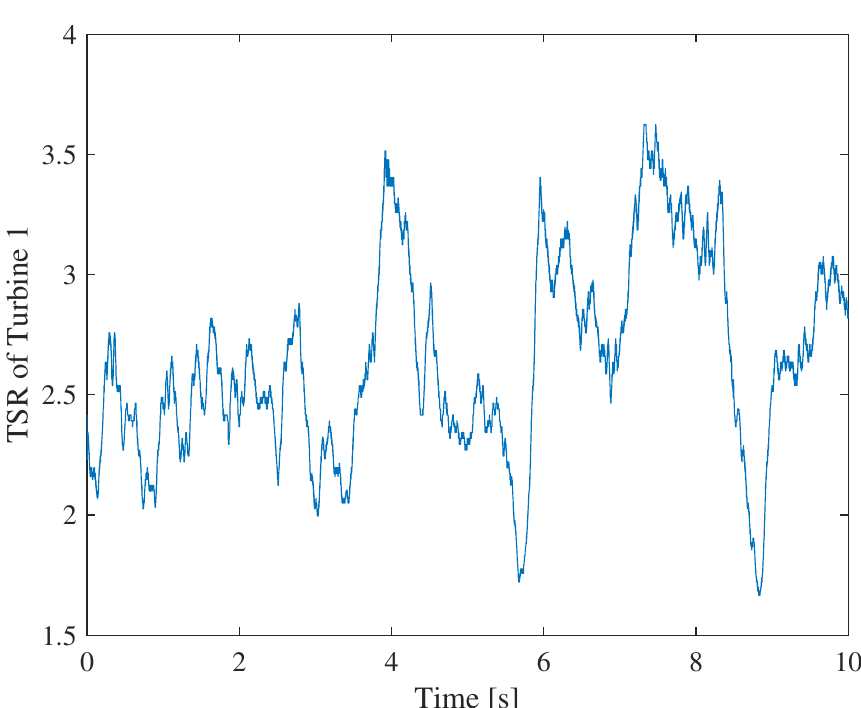
Figure 18. The first ten seconds of turbine one’s TSR during the